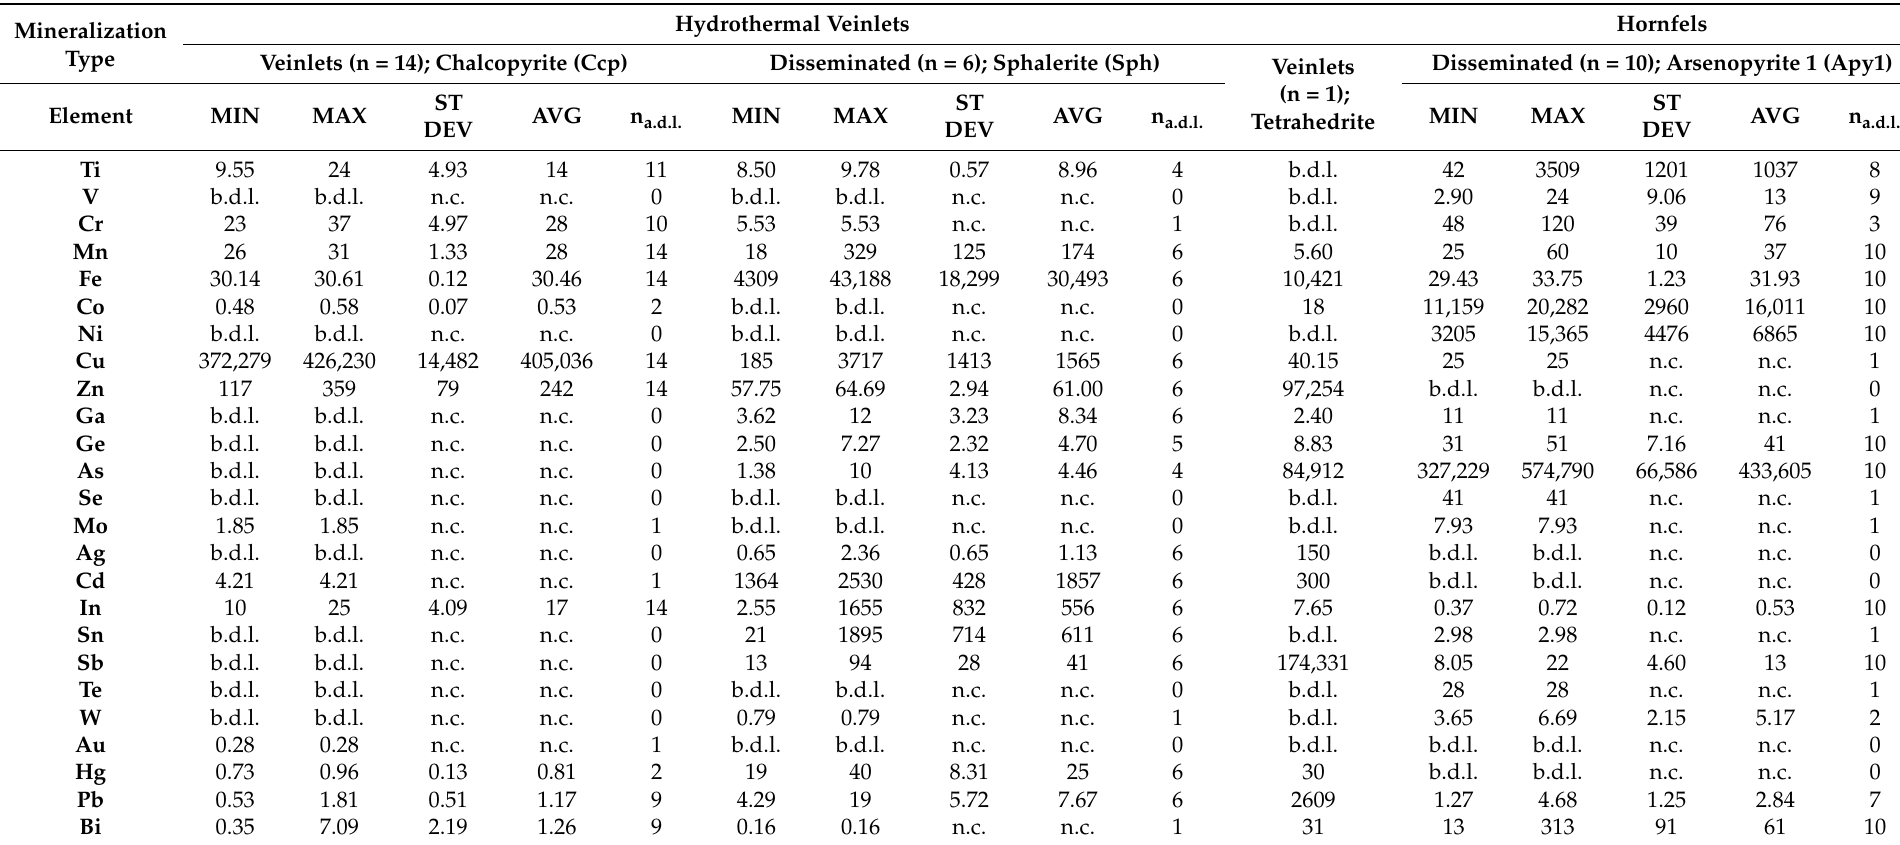
Table 4. LA-ICP-MS analyses of chalcopyrite, sphalerite, and tetrahedrite from Kizhnica quarry and arsenopyrite from hornfels. Values are in ppm, Fe in wt. % for chalcopyrite and arsenopyrite (microprobe), Zn in wt. % for sphalerite (microprobe), and Cu in wt. % for tetrahedrite (microprobe). Mineralization